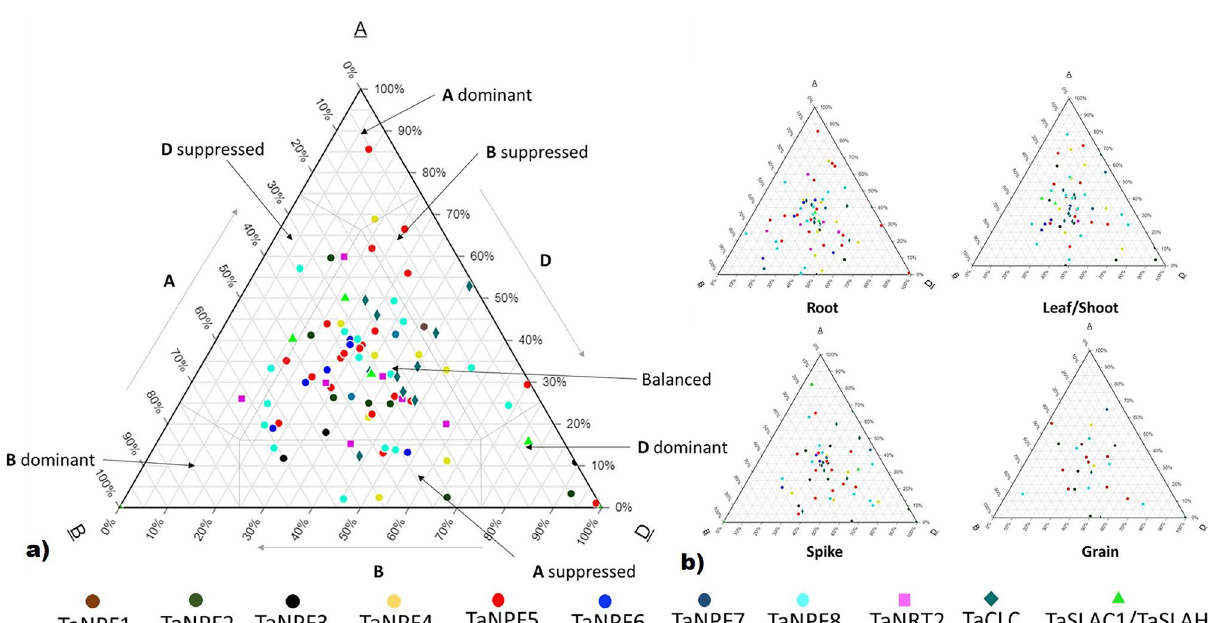
Figure 6. Triad expression of nitrate transporters in wheat ( A ) Overall triad expression of all nitrate transporter genes ( B ) Tissue specific triad expression of nitrate transporter genes. Normalized expression values were used to generate ternary plots using online web-based tool (https:// www. terna ryplot.